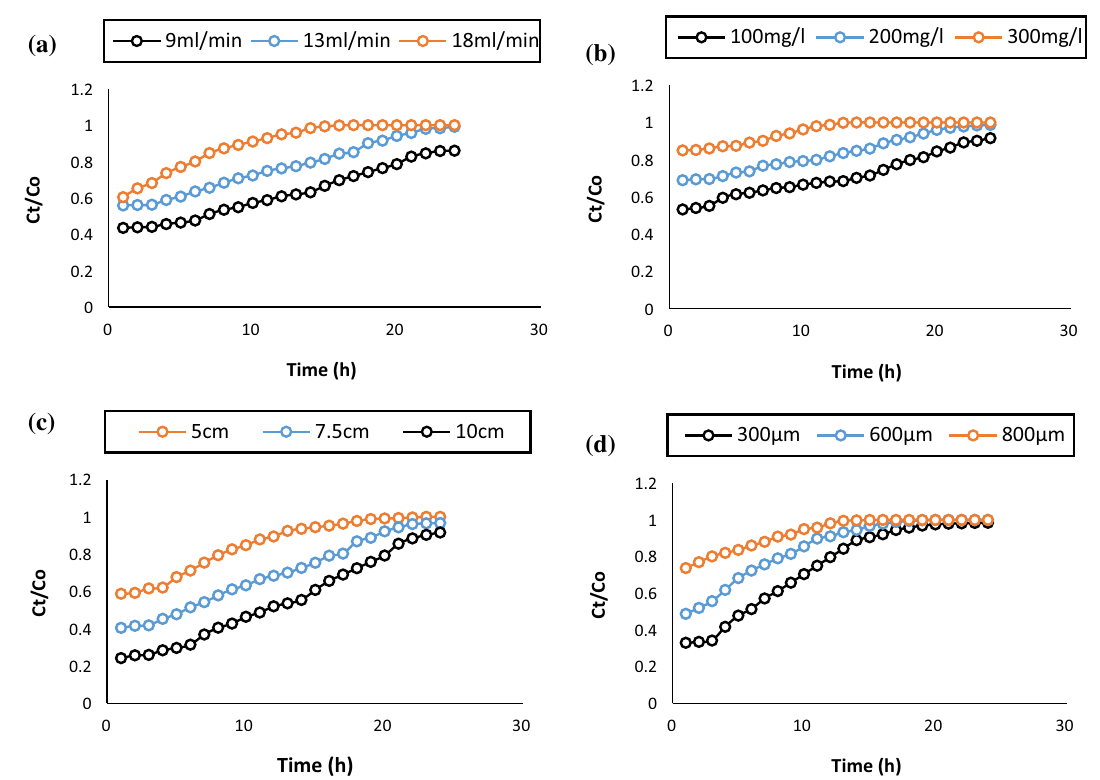
Fig. 4 Effects of operating parameters on breakthrough curves a Effect of flowrate, b Effect of inlet phenol concentration, c Effect of bed height, d Effect of particle size Table 5 Breakthrough parameters for the adsorption of phenol onto RHAC Column adsorp- tion